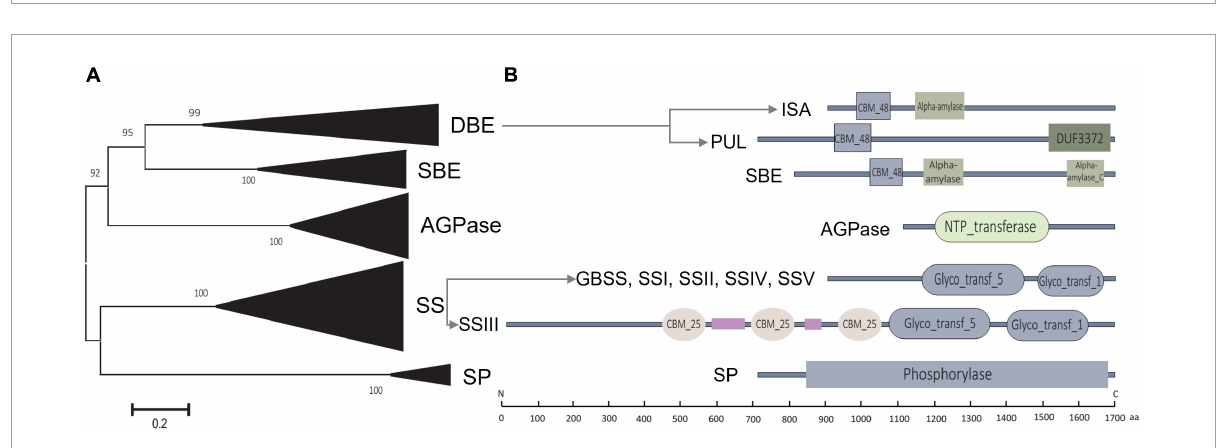
categories according to their expression patterns ( Figure 3B